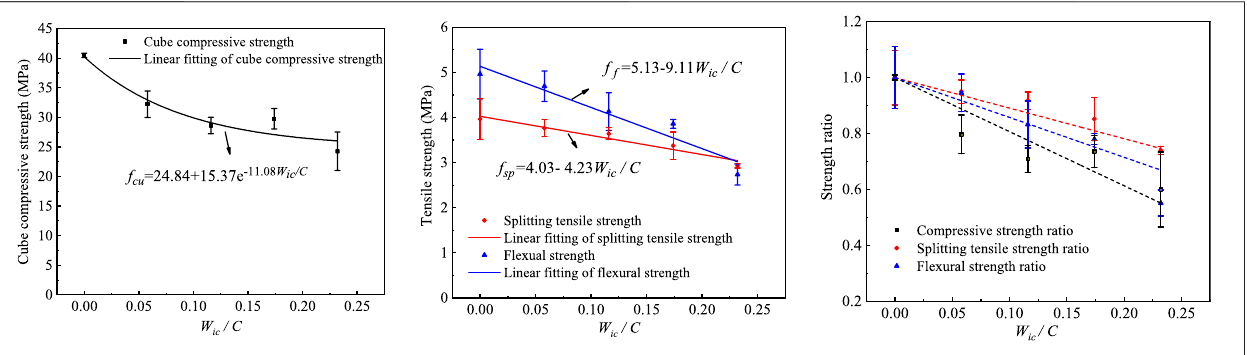
FIGURE 3 | Variation of uniaxial strength of concrete with different SAP content. (A) Relationship of cubic compressive strength and internal curing water-cement ratio, (B) Relationship of tensile strength and internal curing water-cement ratio, (C) Variation rate of uniaxial strength with different SAP content.